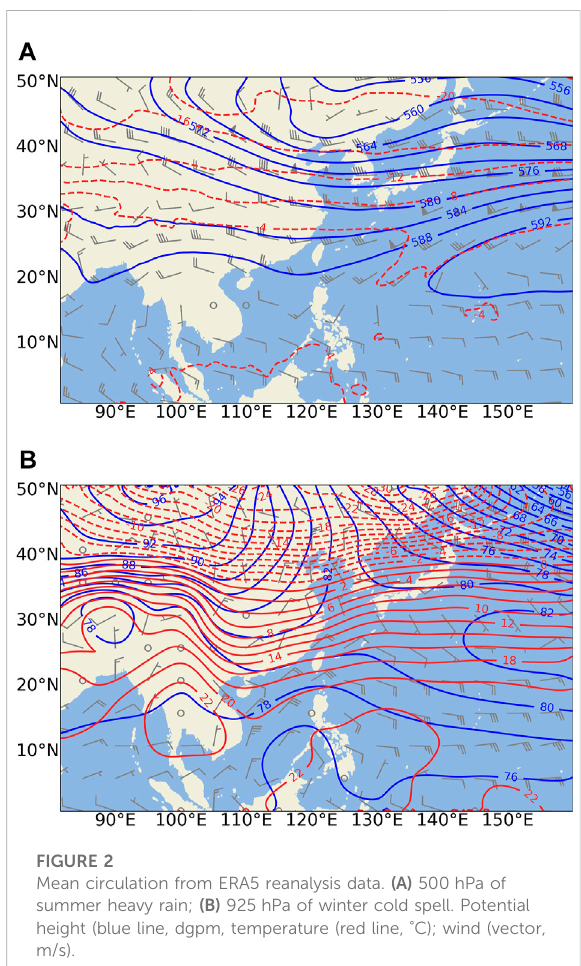
FIGURE 2 Mean circulation from ERA5 reanalysis data. (A) 500 hPa of summer heavy rain; (B) 925 hPa of winter cold spell. Potential height (blue line, dgpm, temperature (red line, ° C); wind (vector, m/s).